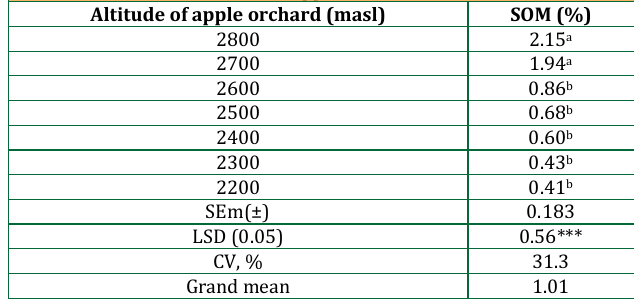
Table 6: Soil organic matter variation in different altitude apple orchards in Apple Zone,